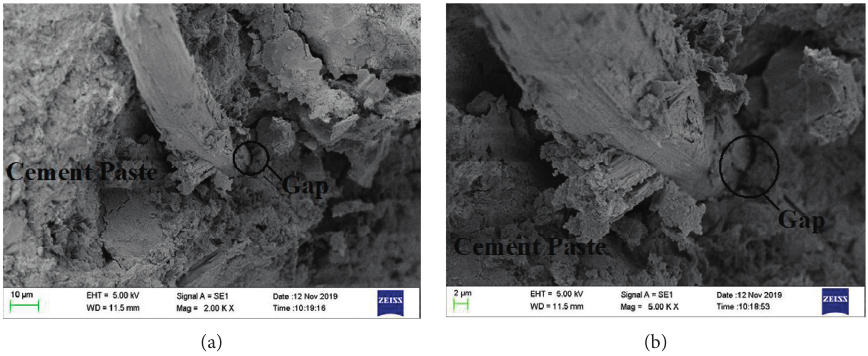
Figure 7: Microstructure of RC-0-1-30 at different magnification. (a) 2.00kx. (b) 5.00kx.